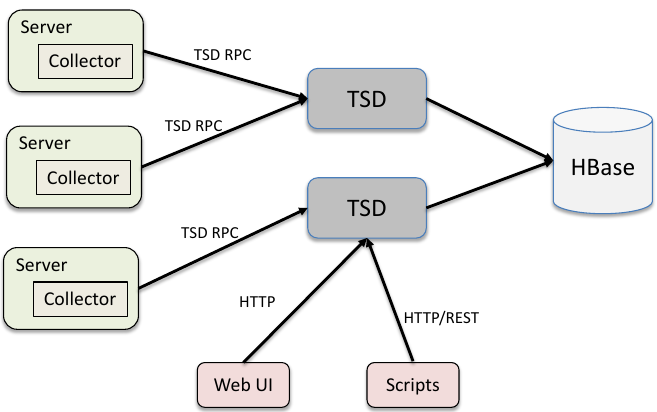
Figure 3. OpenTSDB